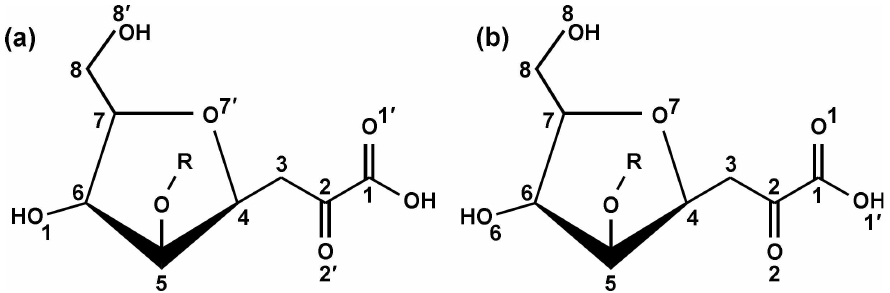
Fig 3. Structure of the 4,7 closure furanoid derivative (anhydro Kdo) of Kdo following LPS delipidation by mild acid hydrolysis and β -elimination of the Kdo O4 substituent, reported by Shrive and co-workers (PDB ID 4E52, ligand KD5). Anhydro Kdo is proposed to be a racemic mixture (Auzanneau et al ., 1991 [43]) with the 2-oxobutanoic acid side chain at C4 both alpha and beta to the glycosidic bond (at C5). (a) Original Kdo numbering retained. (b) Numbering according to pdb entry 4E52 (alpha) and used for the structure